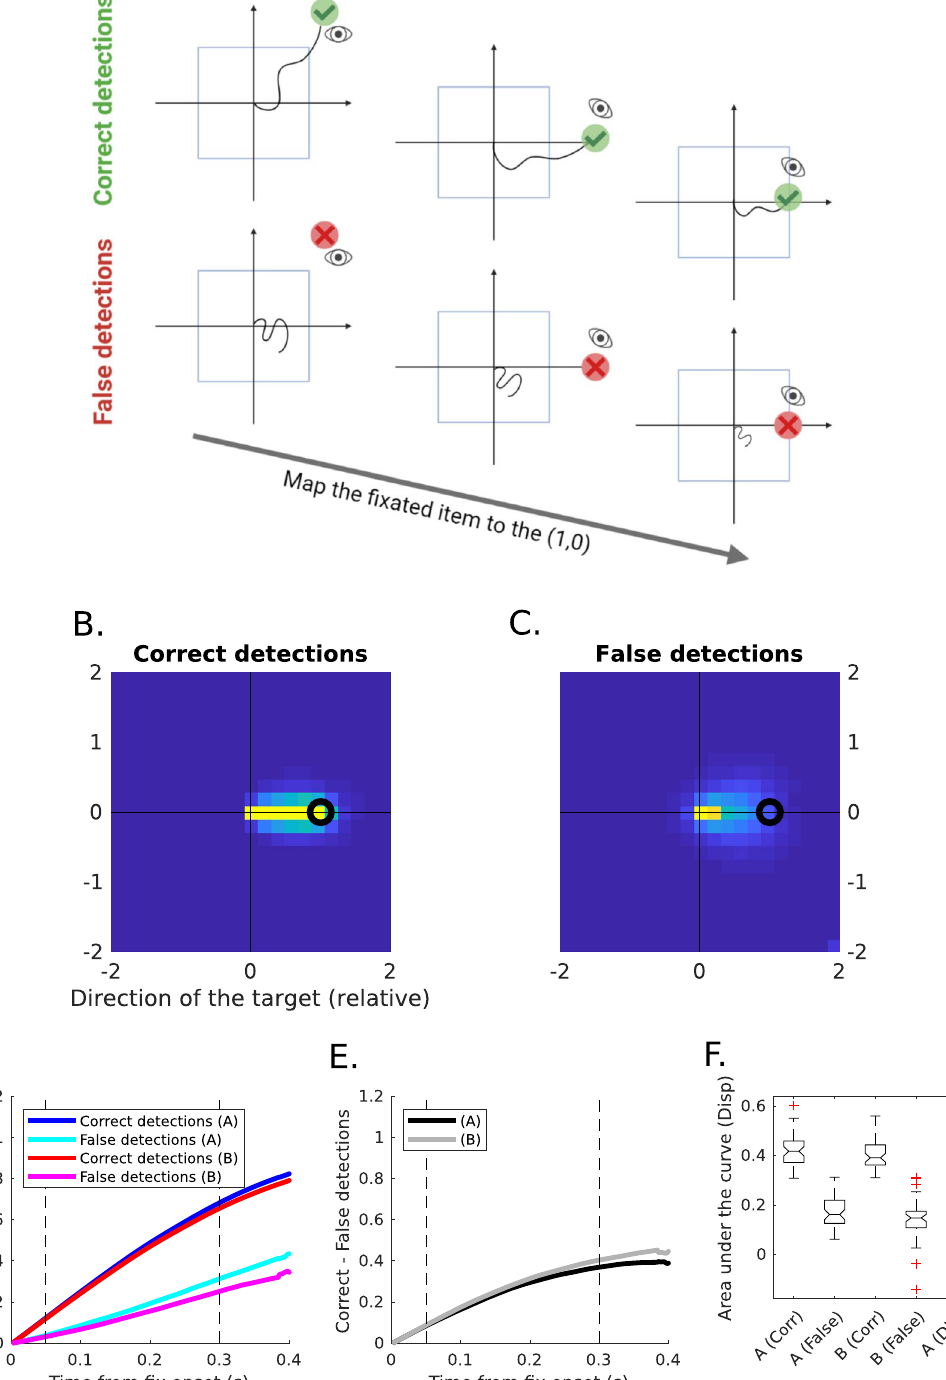
Figure 5. ( A ) Diagram showing the difference between the Correct detections and the False detections. ( B,C ) Spatial distribution of the paths explored by the hand when fixating a new item, for Correct (next in the sequence; B ) and False ( C ) detections. 2-D paths were aligned and normalised so that the fixated item was at (0,1) (see Fig. S3). ( D ) Relative displacement towards the fixated item, in the direction of the item. Curves are aligned to the fixation onset. Red: TMT-A, Correct; Magenta: TMT-A, False; Blue: TMT-B, Correct; Cyan: TMT-B, False. ( E ) Difference between Correct and False detections for displacement. Black: TMT-A; Grey: TMT-B. ( F ) Area under the difference curves for the displacement. The area was calculated participant-by- participant between 50 and 300